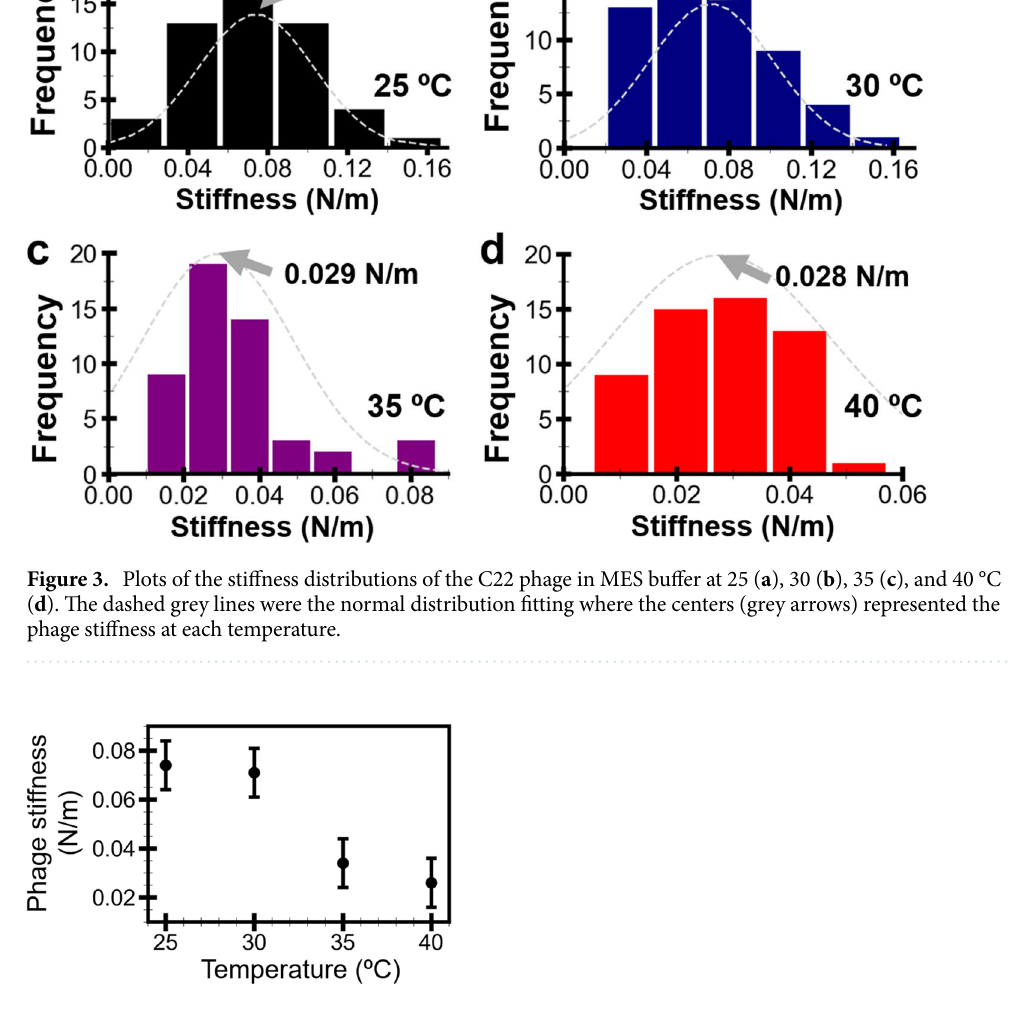
Figure 4. The C22 phage stiffness decreased as the temperature increased from 25 to 40 °C. The error bars represented standard deviation